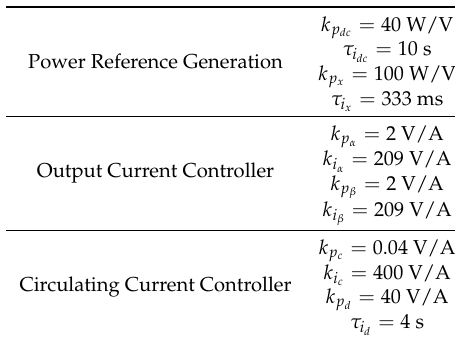
Table A2. Controller parameter.